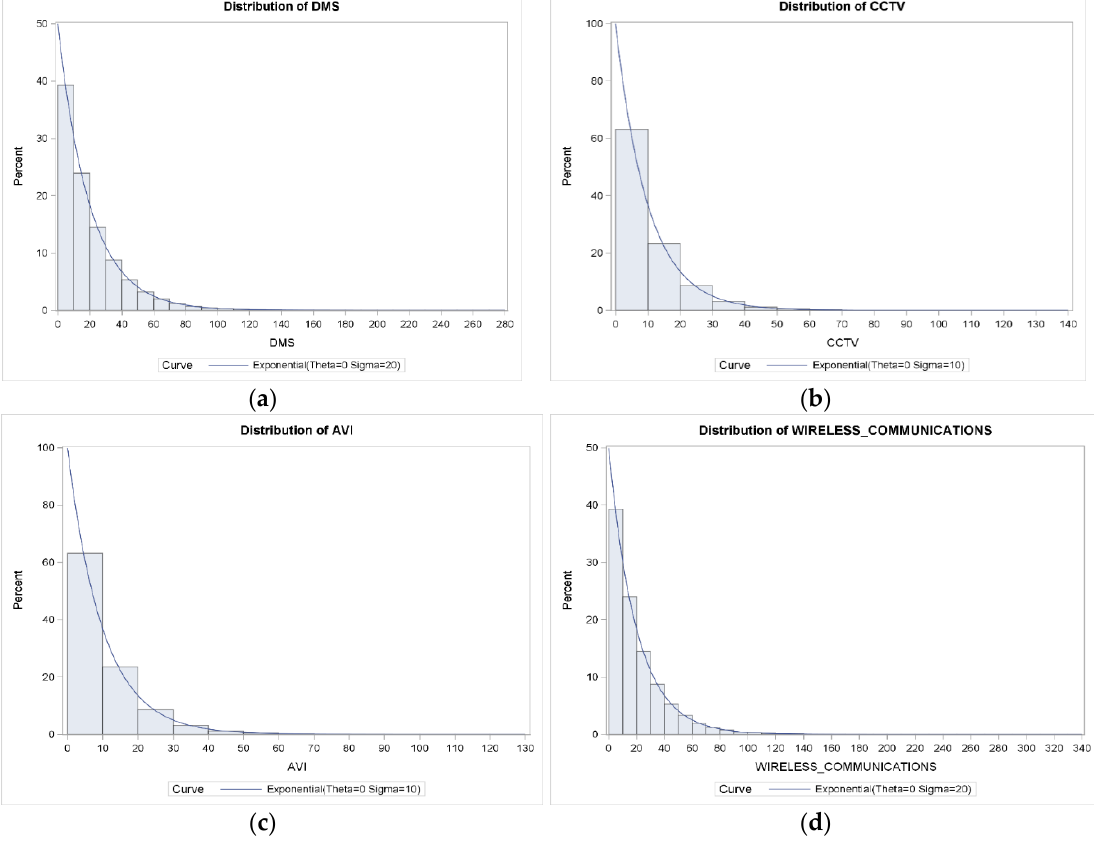
Figure 3. Distributions of the typical lifetimes (age) of ITS devices: ( a ) DMS lifetime distribution plot, ( b ) CCTV lifetime distribution plot, ( c ) AVI lifetime distribution plot ( d ) Wireless Communications lifetime distribution plot.